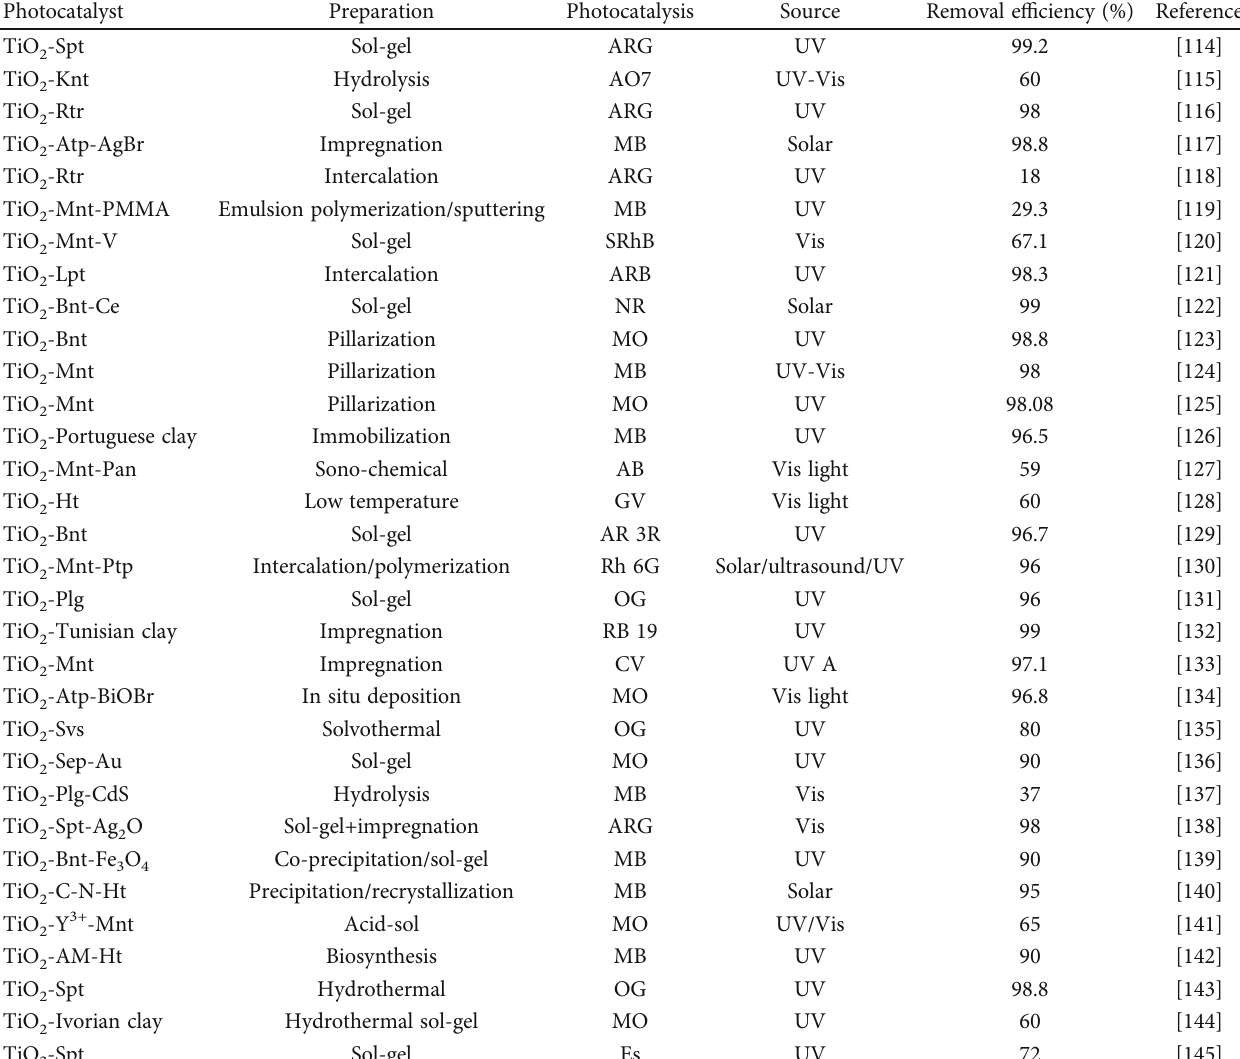
-clay composites over the last 2